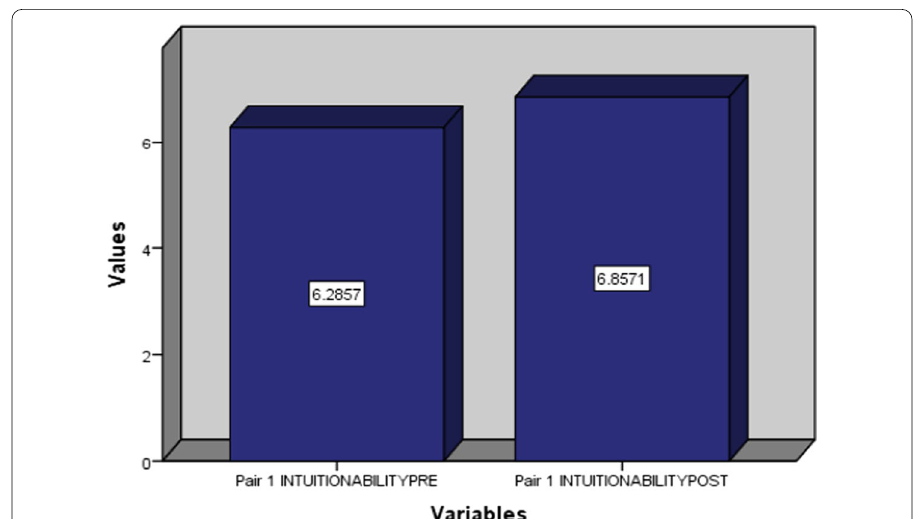
Fig. 7 Paired samples statistics: intuition ability. Source: SPSS 23.0 output